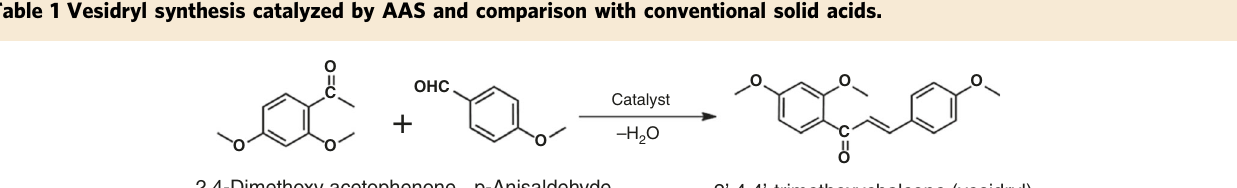
Entry no. Reaction temperature: 150 °C 1